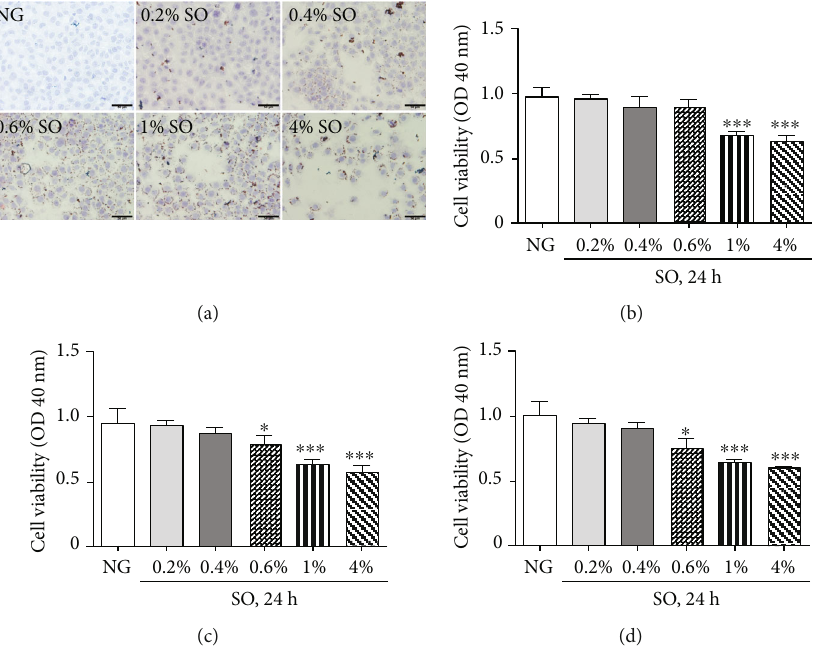
Figure 1: Cell modeling of PNALD in vitro . (a) Rat normal hepatocytes BRL were treated with di ff erent concentrations of soybean oil emulsion (SO). The degree of steatosis in BRL cells was determined by Oil Red O staining. Scar bar: 50 μ m. (b) BRL cell viability was analyzed by the method of CCK-8 after treated with SO. NG: not given (BRL cells untreated with SO). The data was presented as mean ± SD ∗∗∗ P < 0 : 001 . (c) BRL cell viability was analyzed by the method of CCK-8 after treatment with SO for 48 h. NG: not given (BRL cells untreated with SO). The data was presented as mean ± SD , ∗ P < 0 : 05 , ∗∗∗ P < 0 : 001 . (d) BRL cell viability was analyzed by the method of CCK-8 after treatment with SO for 72h. NG: not given (BRL cells untreated with SO). The data was presented as mean ± SD , ∗ P < 0 : 05 , ∗∗∗ P < 0 : 001 .